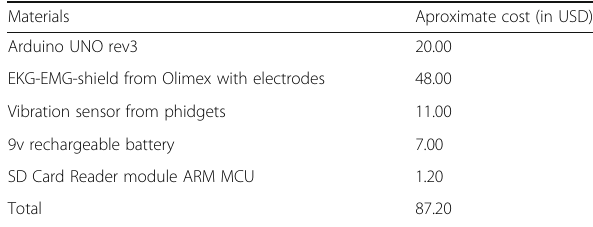
Table 4 (abstract A13). Materials and cost